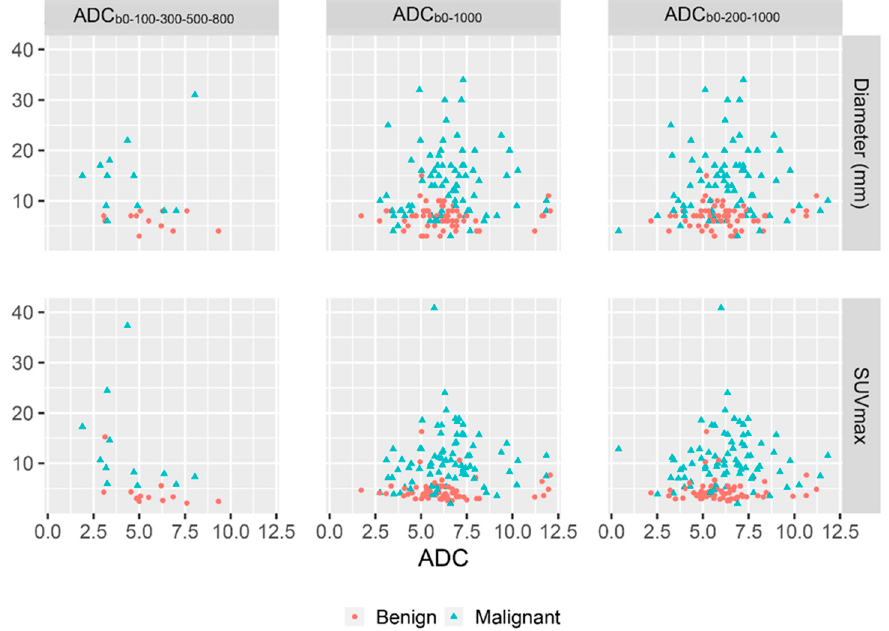
Figure 2. Relationship between ADC and SUVmax, and between ADC and axial node diameter. Table 6. Correlations between ADC and SUVmax, and between ADC and axial node diameter. Variable